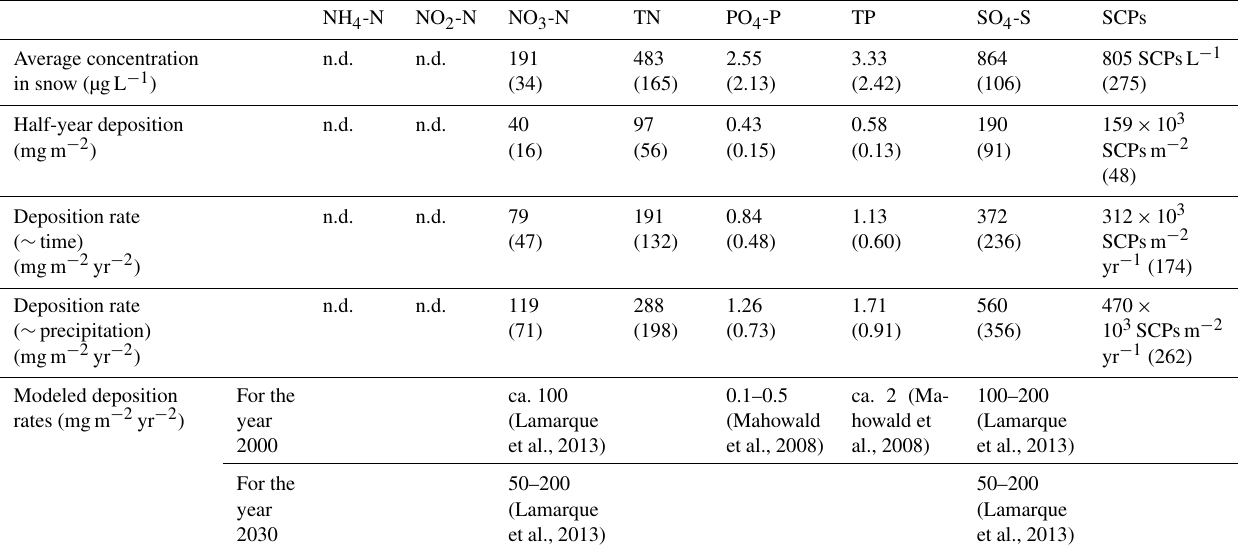
Table 2. Average concentrations, half-year depositions and estimated yearly deposition rates, as averaged by the three sampled sites (µgL − 1 , mgm − 2 and mgm − 2 yr − 1 , respectively) (SCPs in countsL − 1 , 10 3 countsm − 2 and 10 3 countsm − 2 yr − 1 ). Mean values are shown, with the standard deviation in parenthesis; “n.d.” means non detected. Yearly deposition rates were estimated on the basis of measured winter depositions and either assuming a constant deposition rate (time-weighted estimate, third row) or a precipitation-dependent deposition rate (precipitation-weighted estimate, fourth row). See Sect. 3.3 for further